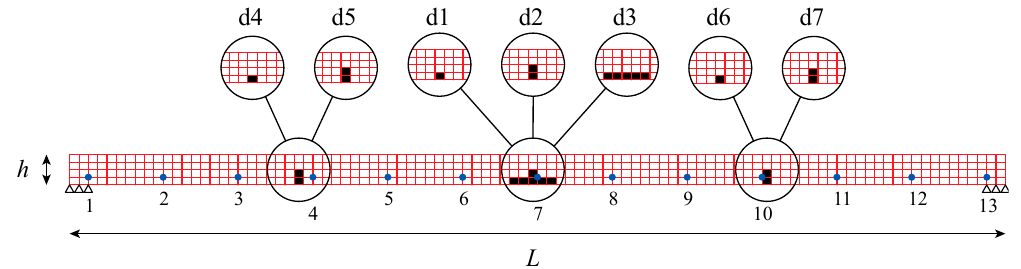
Figure 3. Numerical benchmark: Finite element model and locations of damage.